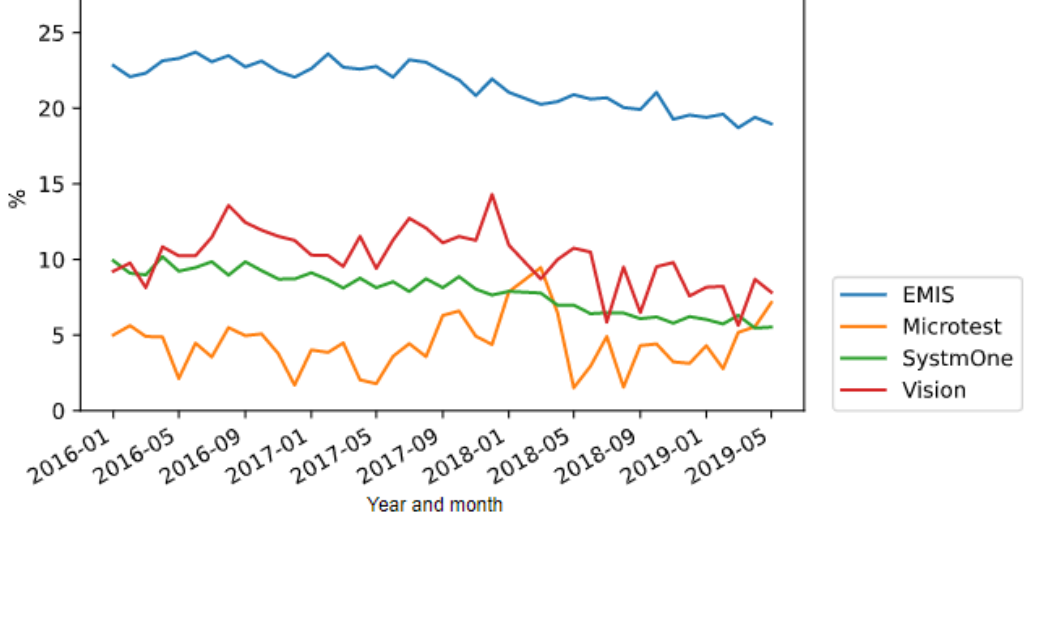
Figure 1. Mean values for the ciclosporin and tacrolimus safety breaches as a proportion of all prescribing by electronic health record